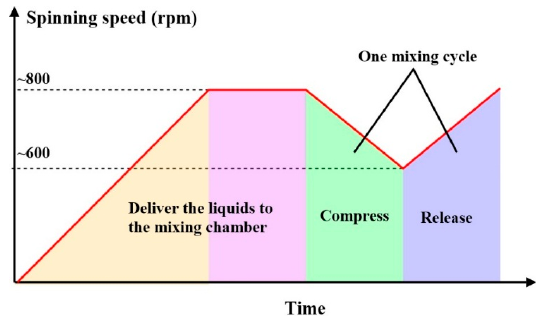
Figure 5. The spinning speed profile followed in the experiments of the mixer. The compressing-releasing times are controlled to be equal.